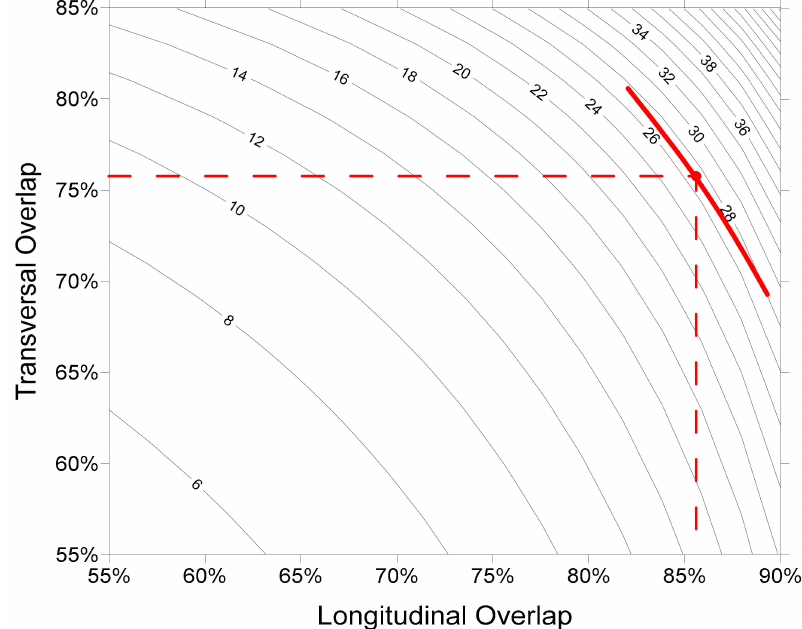
Figure 2. Effective overlap index of the project is 27, roughly equivalent to a sidelap of 76% and an endlap of 86%.